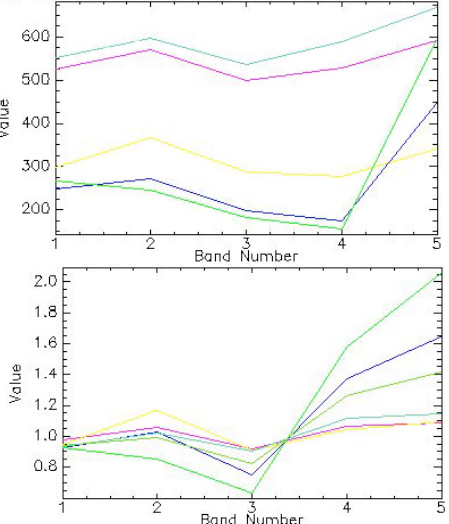
Figure 2. The mean of brightness before and after